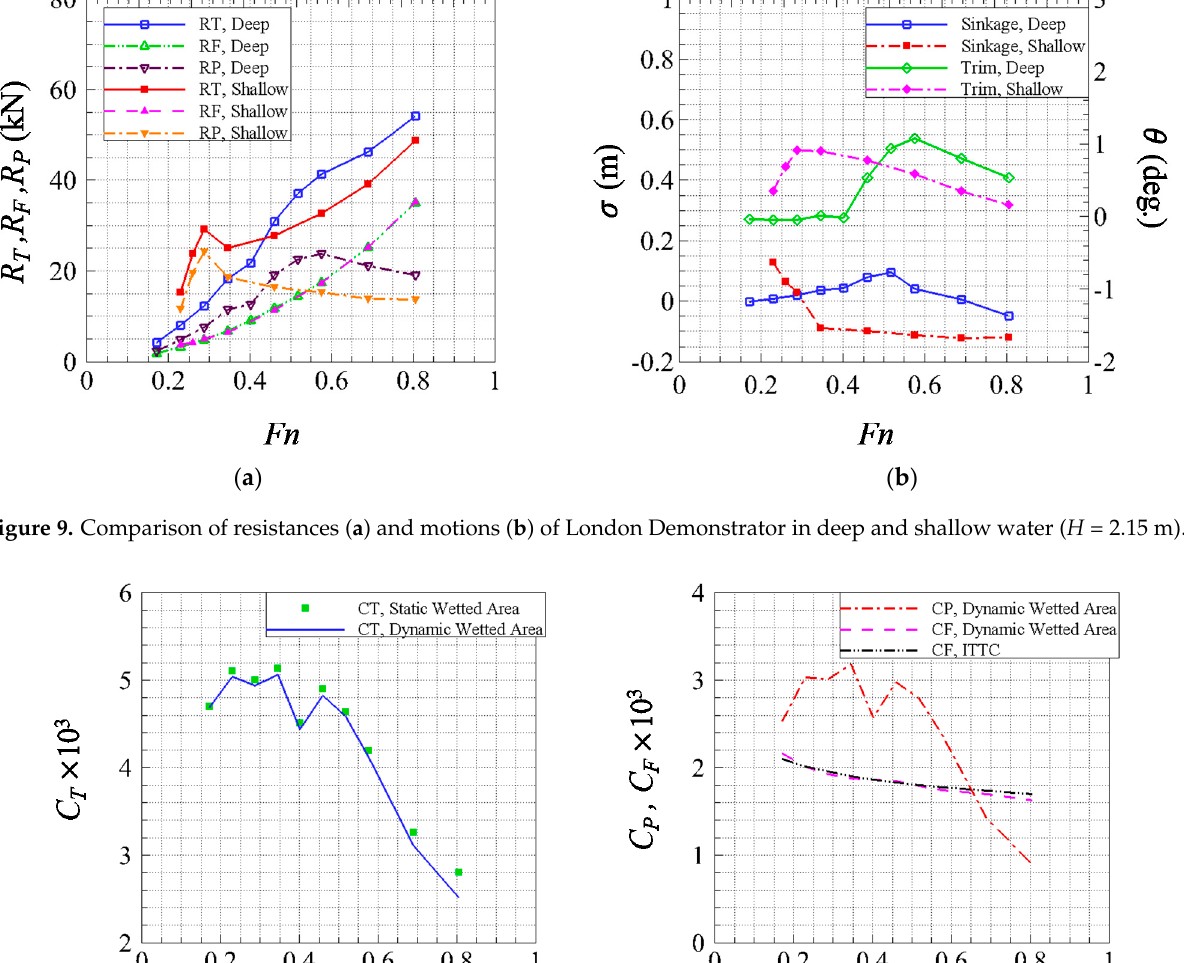
( b ) Figure 11. Total resistance coefficient ( a ), and pressure and frictional resistance coefficients ( b ) of the London Demonstra- tor in shallow water.